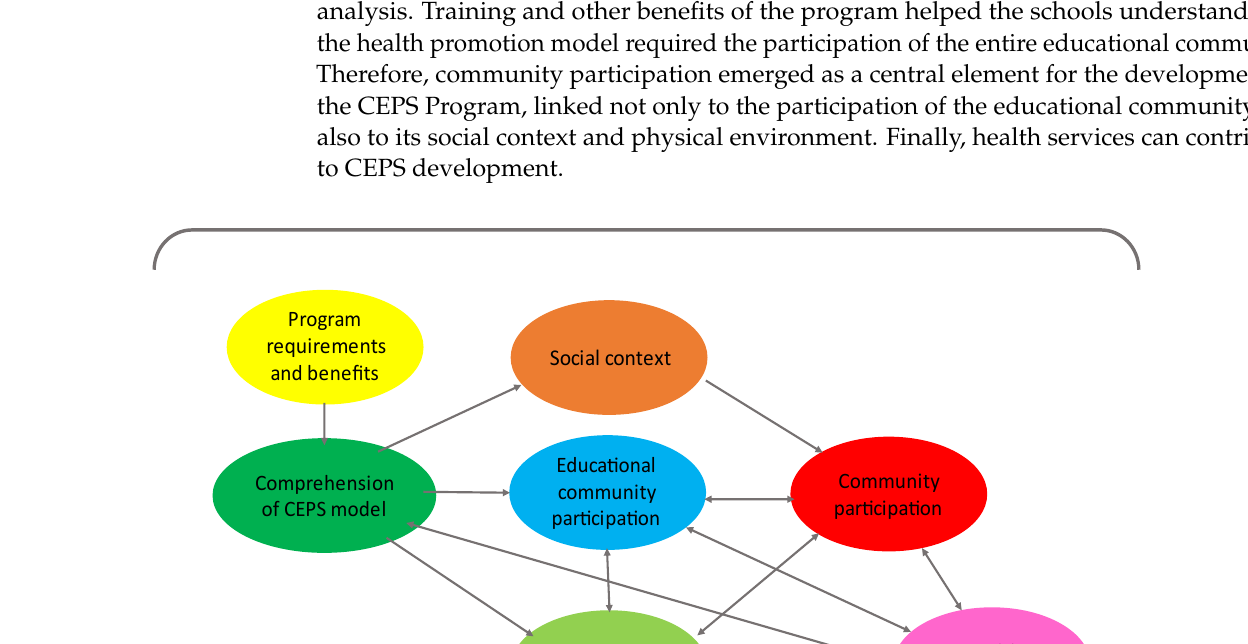
Figure 1. Model for development of CEPS.